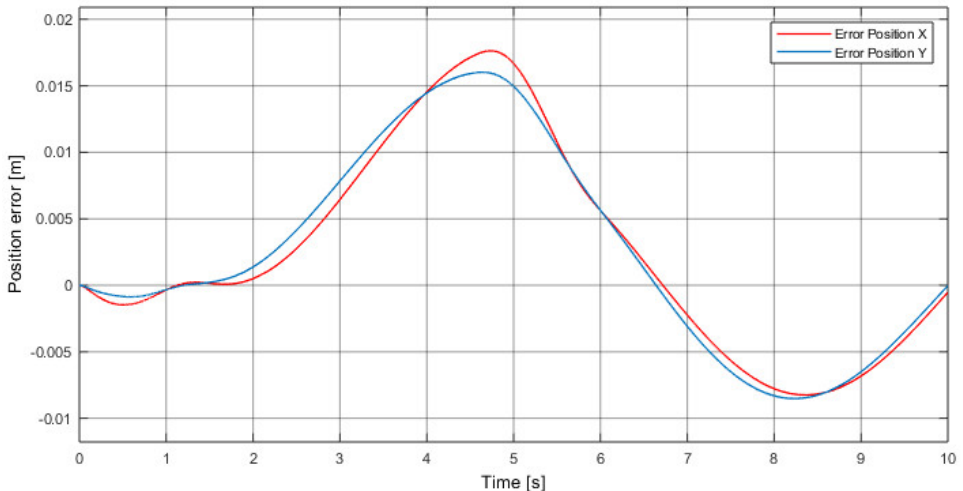
Figure 25. Error signal developed during robot movement under the action of a PID controller.